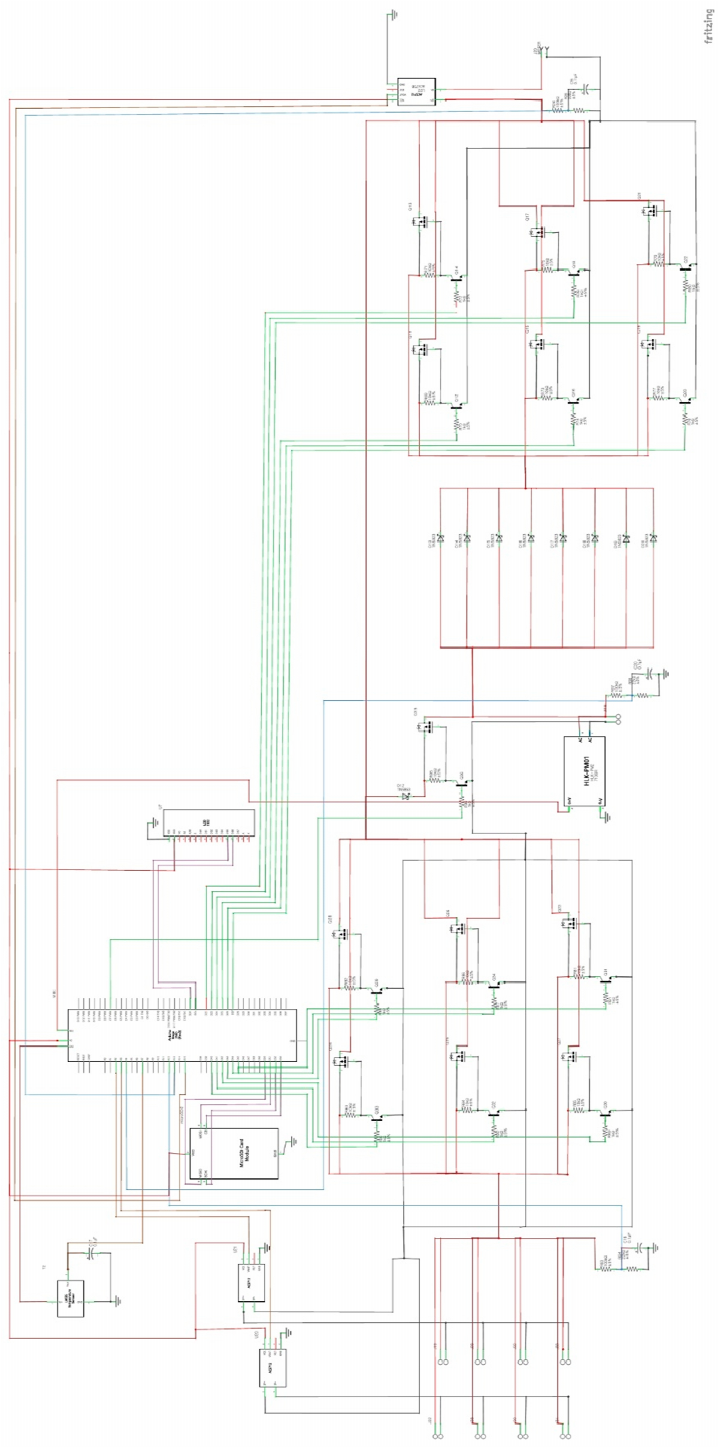
Figure A1. Schematic of PPMS.